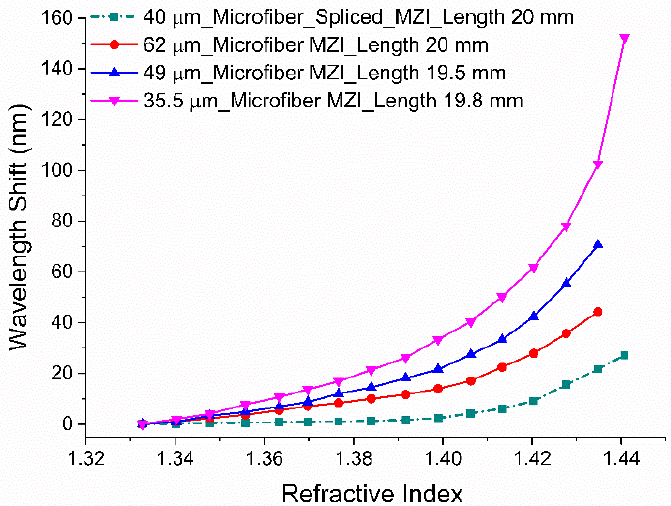
Figure 7. The spectral shift of the microfiber MZIs, with various waist diameters, due to changes in RI.